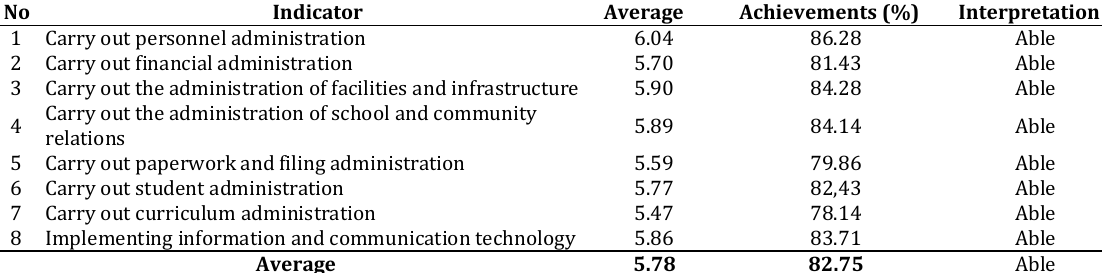
Table 1 The results of research on the technical competence of school administrative personnel No Indicator Average Achievements (%)